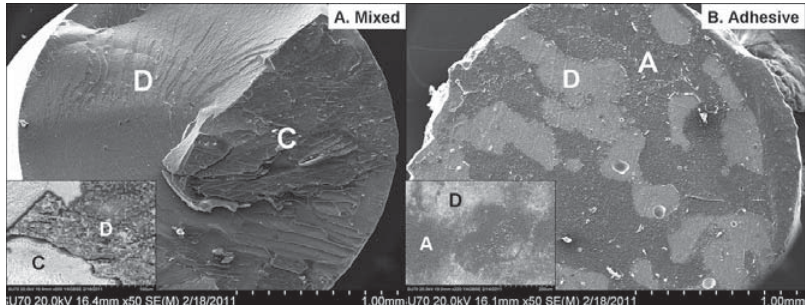
Figure 1- FE-scanning-electron microscopy (SEM) images in secondary electron and back-scattered electron mode of the fractured interface for representative failure modes. 1.A. Mixed failure: towards the right, large cohesive failure in (cid:13)(cid:4)(cid:9)(cid:20)(cid:4)(cid:12)(cid:10)(cid:14)(cid:15)(cid:16)(cid:5)(cid:15)(cid:12)(cid:10)(cid:11)(cid:16)(cid:29)*#<(cid:16)(cid:14)(cid:4)(cid:24)(cid:7)(cid:5)(cid:21)(cid:12)(cid:16)(cid:14)%(cid:15)(cid:16)(cid:8)(cid:15)(cid:23)(cid:14)(cid:18)(cid:16)(cid:13)(cid:4)%(cid:15)(cid:12)(cid:10)>(cid:15)(cid:16)(cid:23)(cid:7)(cid:10)(cid:8)(cid:3)(cid:5)(cid:15)(cid:16)(cid:10)(cid:11)(cid:16)(cid:21)(cid:15)(cid:11)(cid:14)(cid:10)(cid:11)(cid:16)(cid:29)?#!(cid:16)Q(cid:5)(cid:15)(cid:7)(cid:14)(cid:15)(cid:5)(cid:16)(cid:9)(cid:7)(cid:17)(cid:11)(cid:10)(cid:22)(cid:13)(cid:7)(cid:14)(cid:10)(cid:4)(cid:11)(cid:16)(cid:4)(cid:23)(cid:16)(cid:14)%(cid:15)(cid:16)(cid:12)(cid:7)(cid:9)(cid:15)(cid:16)(cid:10)(cid:9)(cid:7)(cid:17)(cid:15)(cid:16)(cid:12)%(cid:4)(cid:24)(cid:12)(cid:16)(cid:7)(cid:5)(cid:15)(cid:7)(cid:16) where the fracture transitions from cohesive failure in composite to cohesive failure in dentin across the different interfacial layers. 1.B. Adhesive failure: spotted areas of adhesive-coated dentin (A) and dentin